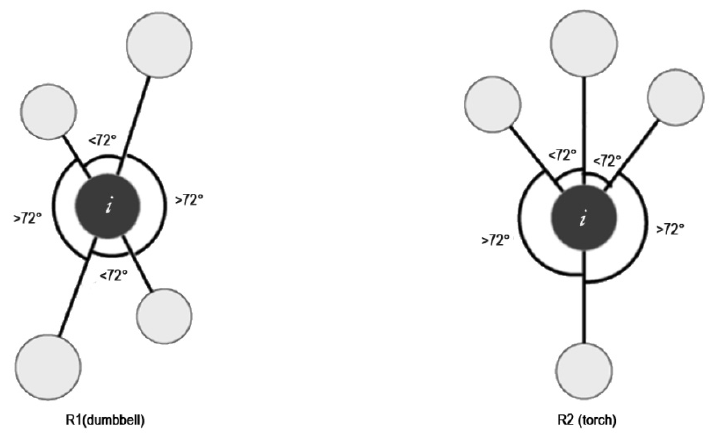
Figure 2. Two types of random structural unit.